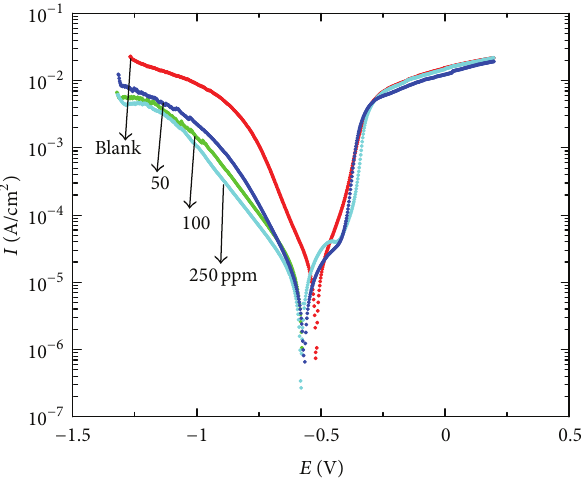
Figure 4: Nyquist diagram for carbon steel in 1M HCl solution showing experimental and fit